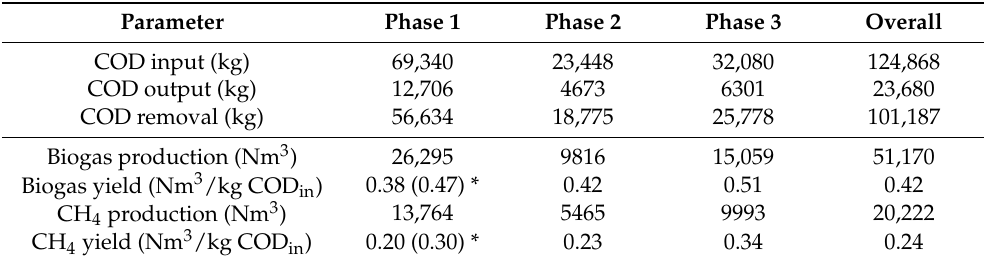
Table 3. Summary of COD balance and biogas production during the